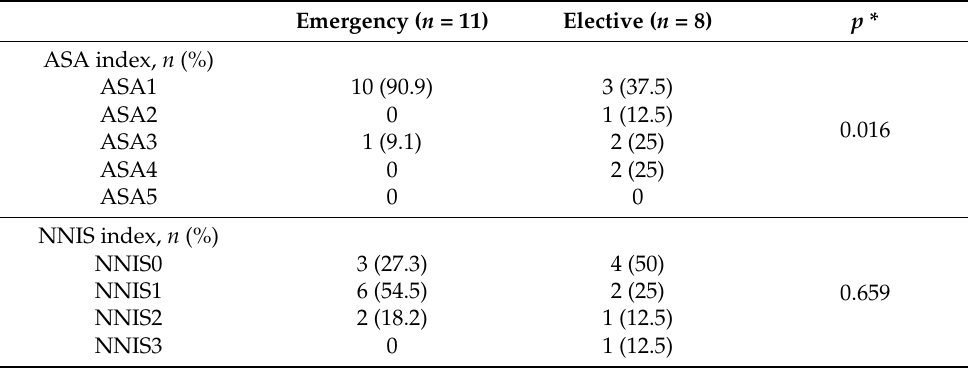
Table 4. ASA and NNIS score in the study group based on the type of primary procedure (elec-